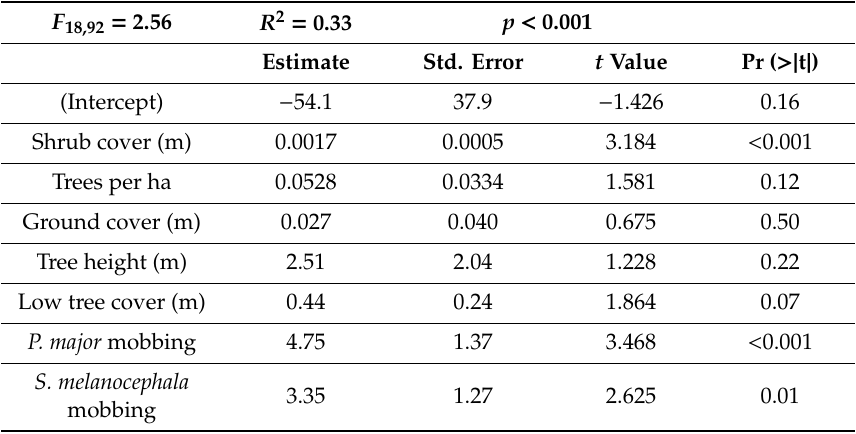
Table 1. Linear model for the number of responding birds to mobbing calls with respect to various parameters of forest vegetation structure.